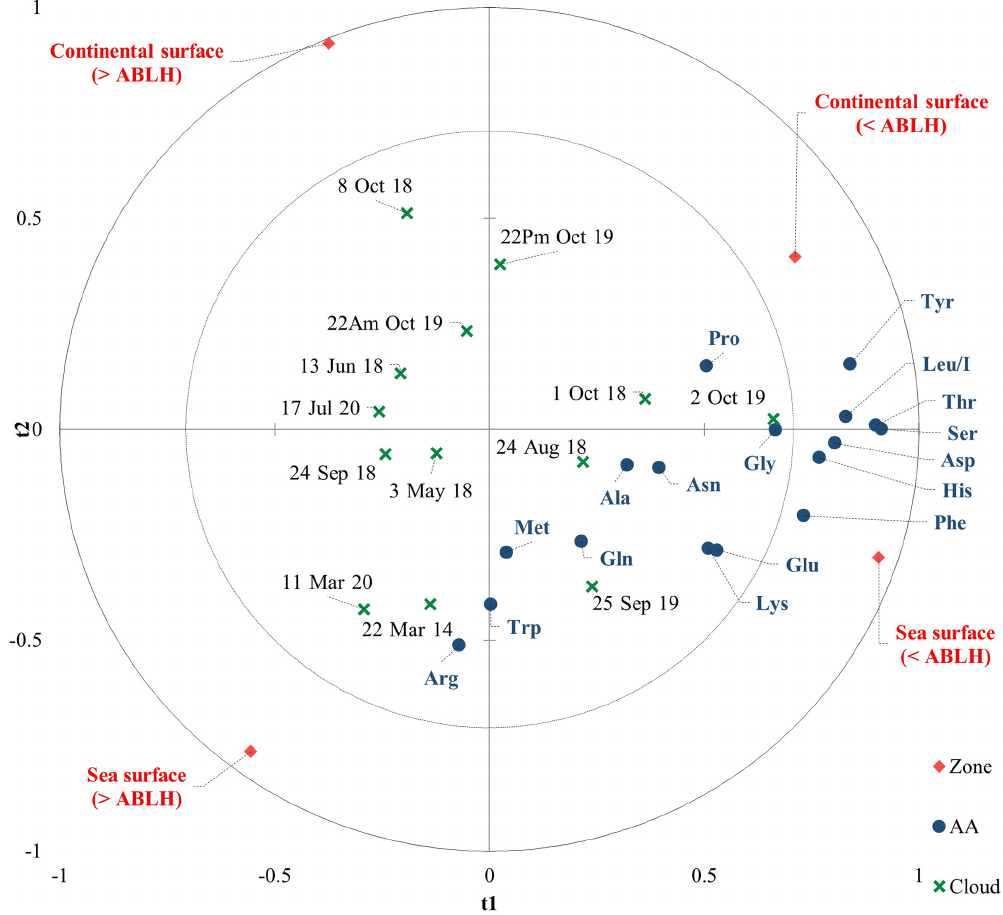
Figure 5. Partial least square (PLS) chart with a t component on axes t 1 and t 2. The correlation map superimposes the dependent variables from the chemical matrix (blue circles), the explanatory variables (red diamonds), and the cloud events (green